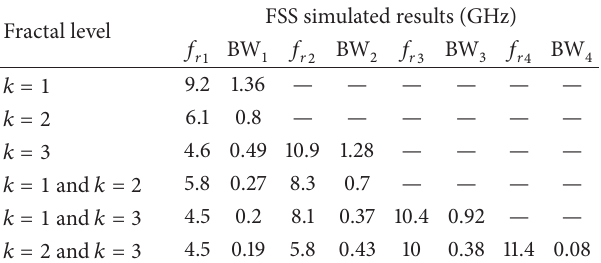
Table 1: Simulated FSS resonant frequencies and bandwidths. Fractal